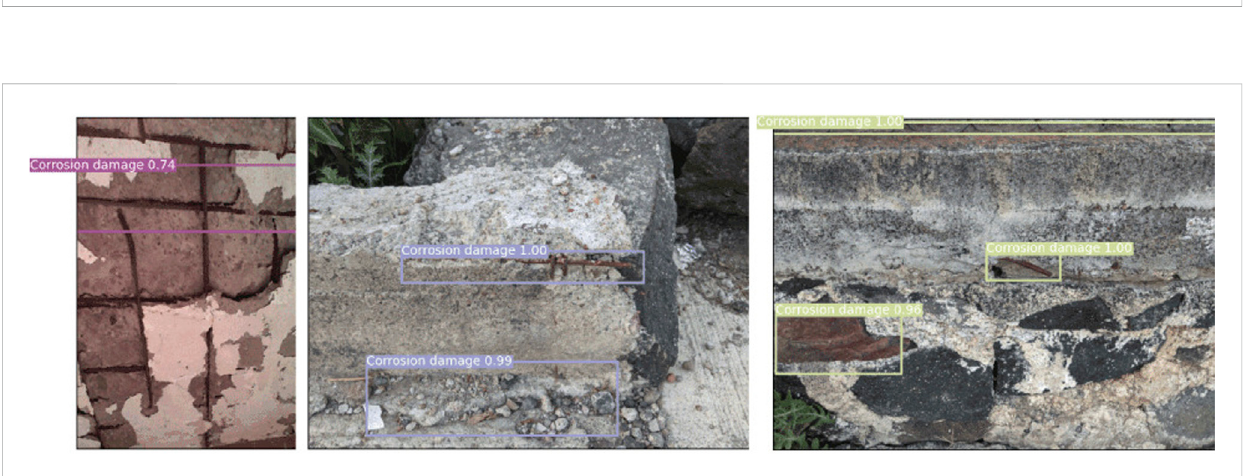
FIGURE 14 False positives and no satisfactory detection on concrete